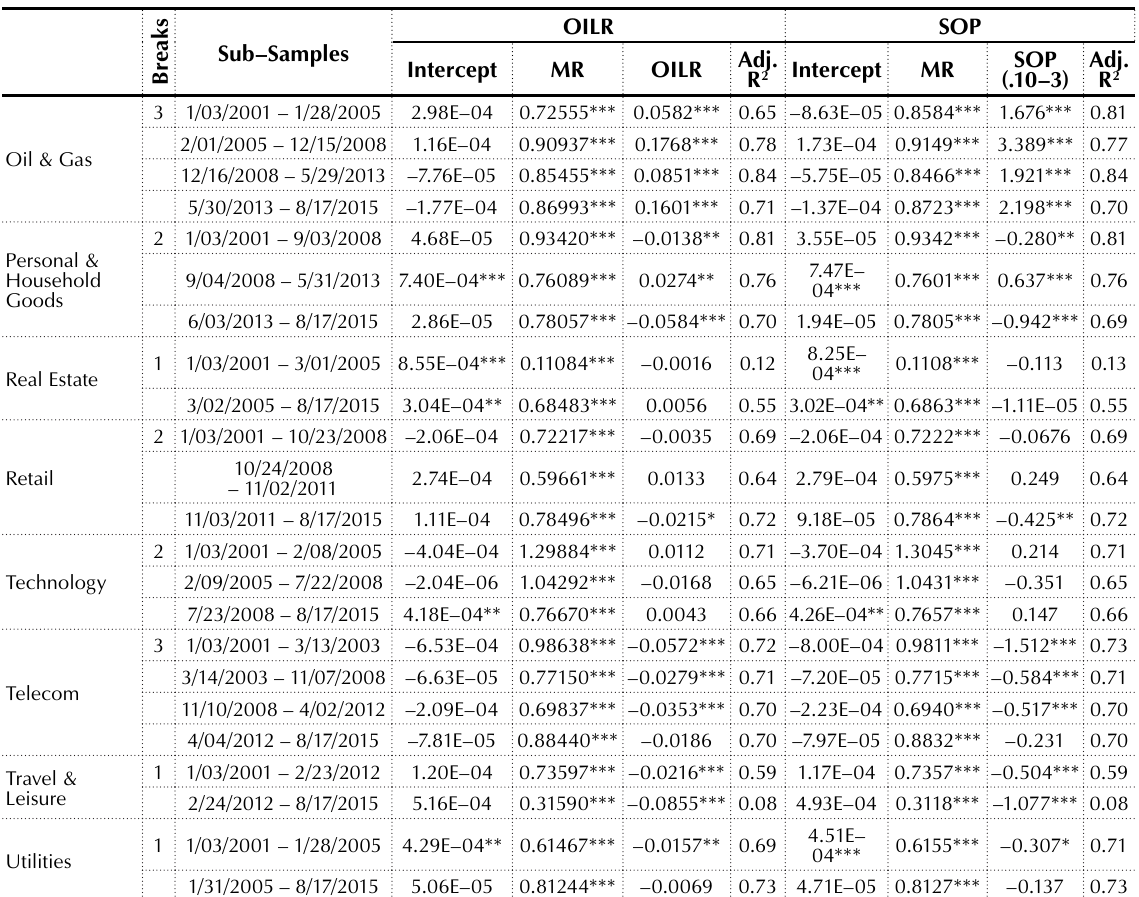
Table 3 (cont). Results of sub-samples estimations with OILR as independent